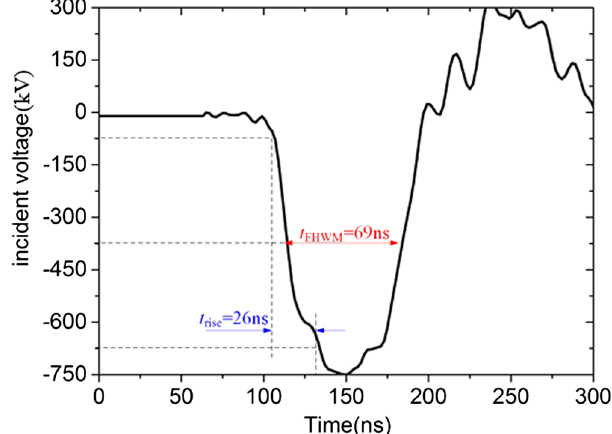
FIG. 3. Incident voltage used in the 3D EM model and circuit simulation. This is the measured load voltage when each pulse line is terminated with a matched load of approximately 6 Ω .